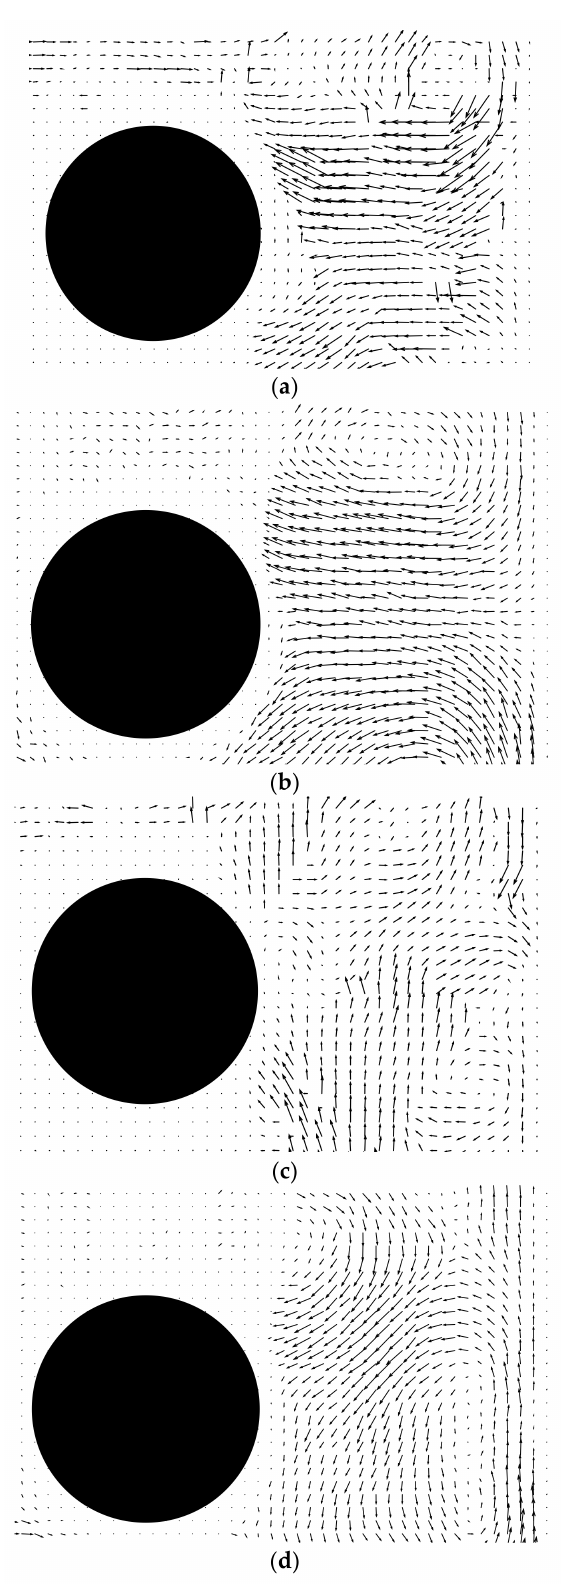
Figure 8. Calculation results of the velocity distributions at z / h = 0.7 ( Q = 0.022 m 3 /s): ( a ) instantaneous velocity (without F-AVD); ( b ) time-averaged velocity (without F-AVD); ( c ) instantaneous velocity (with F-AVD); and ( d ) time-averaged velocity (with